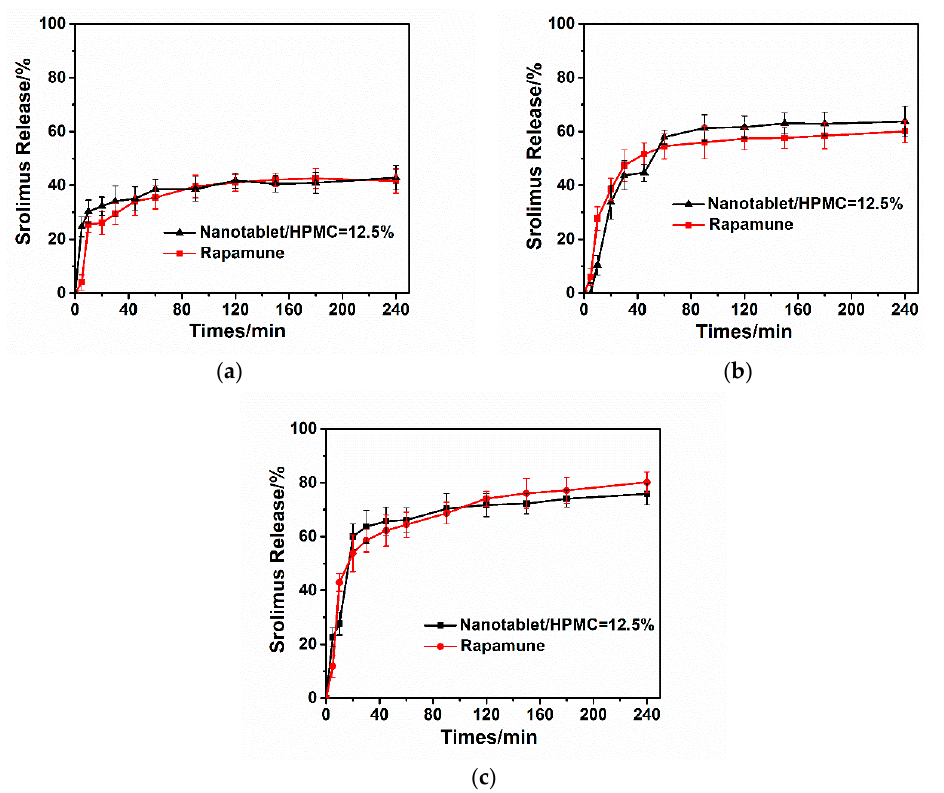
Figure 13. Dissolution profiles of optimized nanotablets and Rapamune ® ( a ) pH = 1.2; ( b ) pH = 4.5; ( c ) pH = 6.8.